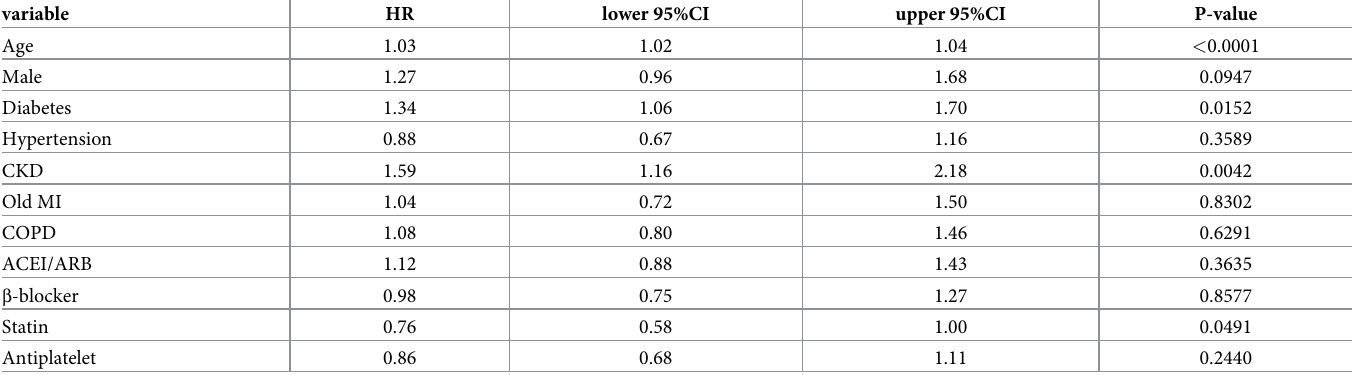
Table 7. Cox regression analysis in CABG